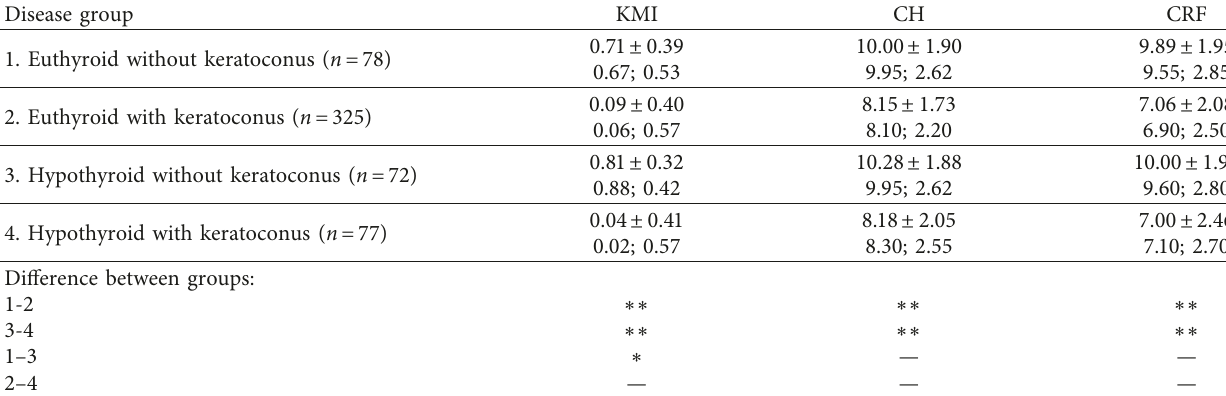
Values represent the mean ± standard deviation or the median; interquartile range, as indicated. ∗ p < 0 . 05; ∗∗ p < 0 . 01. KMI: keratoconus match index; CH: corneal hysteresis; CRF: corneal resistance factor. Table 5: Corneal endothelium evaluated with the EM-3000 specular microscope in different disease groups. Disease group